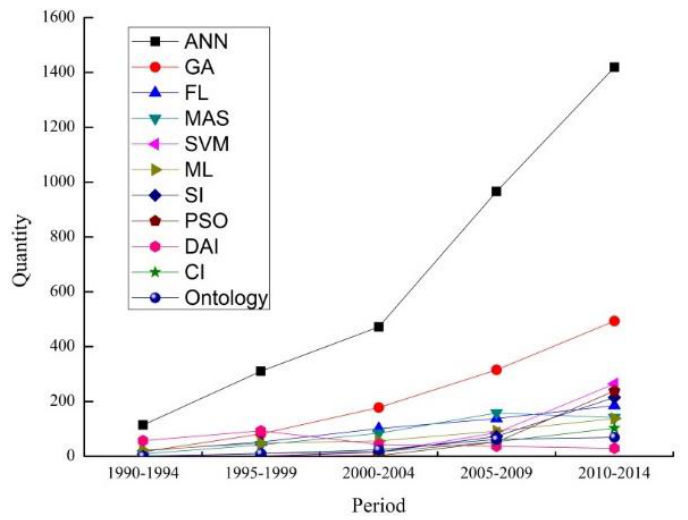
Figure 6. Trends of keywords with respect to method and model.